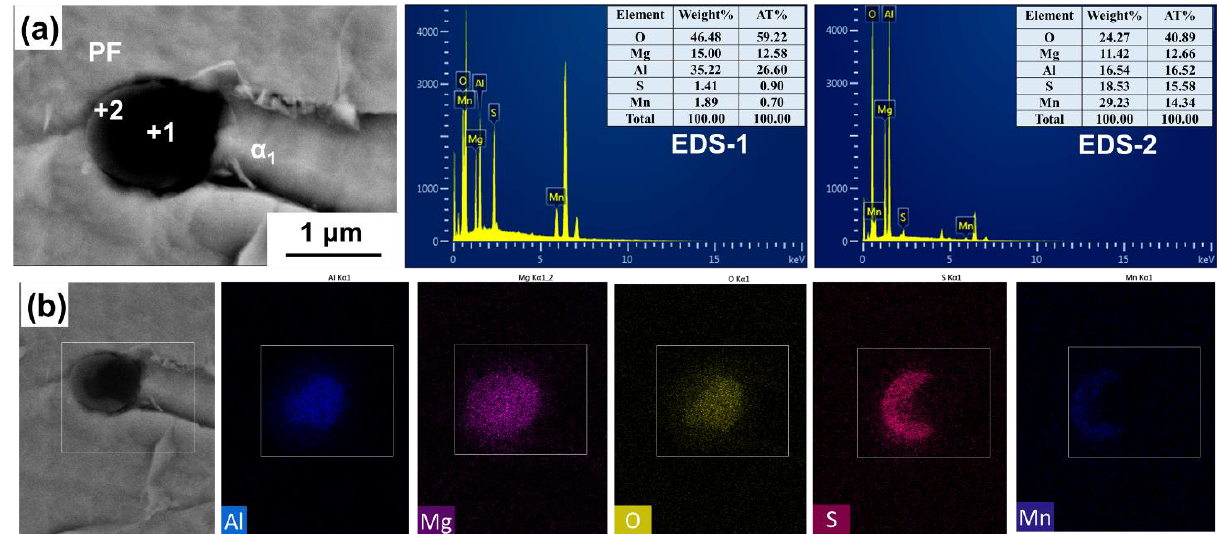
Figure 14. Mapping scanning results and the relationship between the Al–Mg–O+MnS and ferrite in the HAZ of Mg-treated steel at W2 heat input: ( a ) EDS analysis; ( b ) mapping analysis.